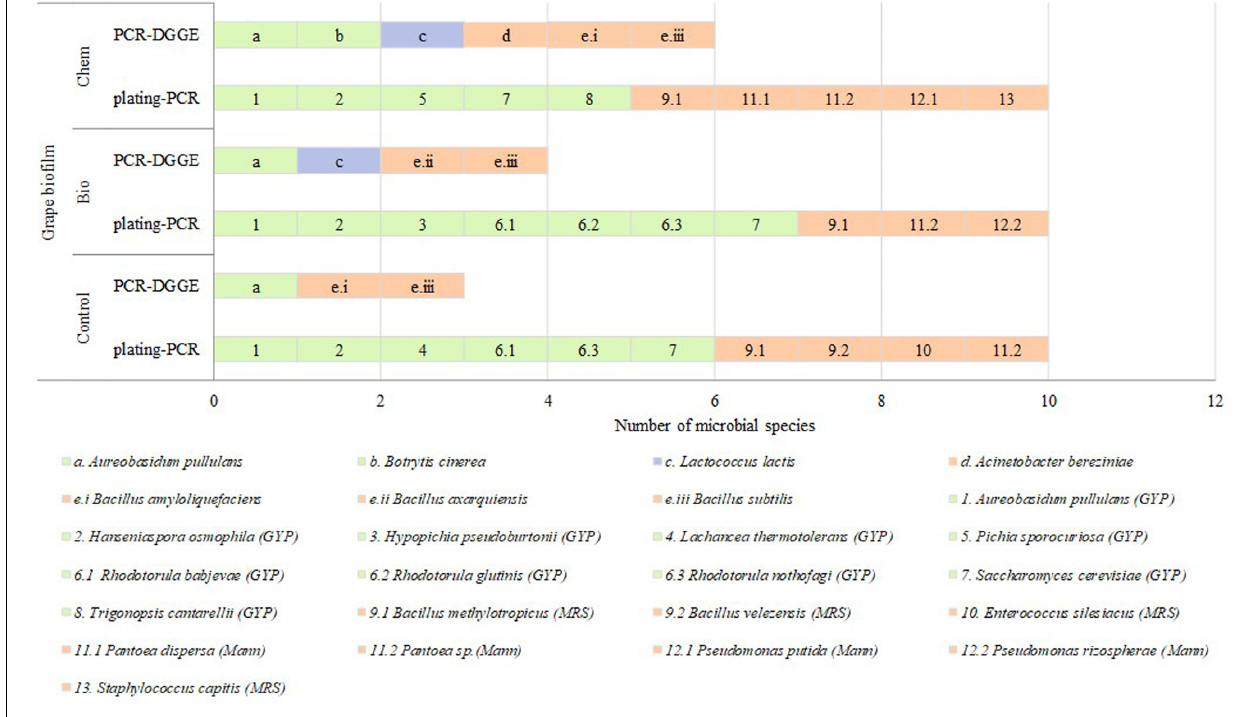
Frontiers in Microbiology |